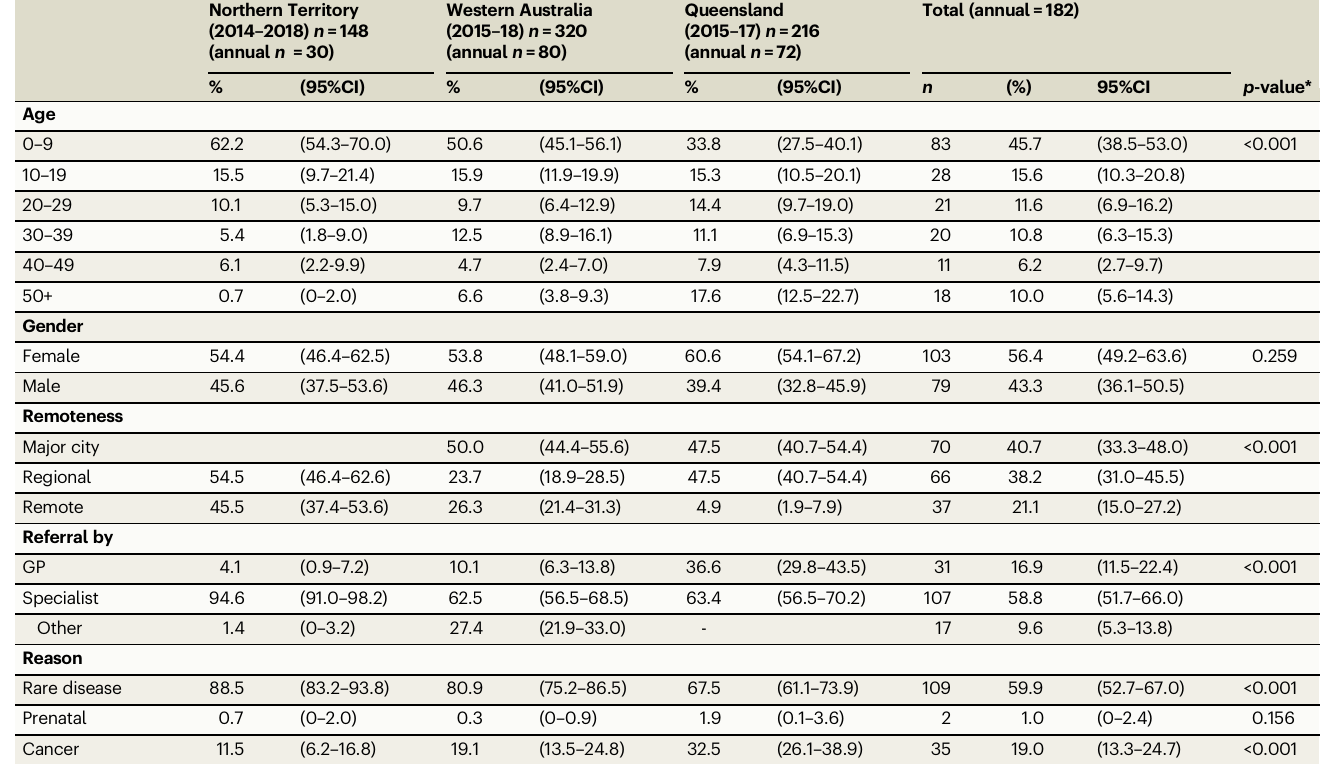
Table 2 | Characteristics of Aboriginal and/or Torres Strait Islander people scheduled an appointment, by